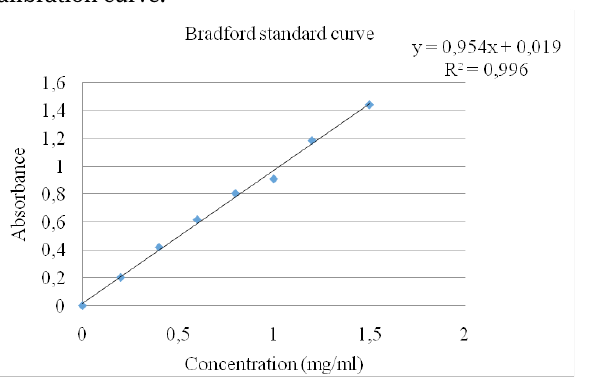
Figure 3: The standard curve for Bradford method Development of bakery products. The production of